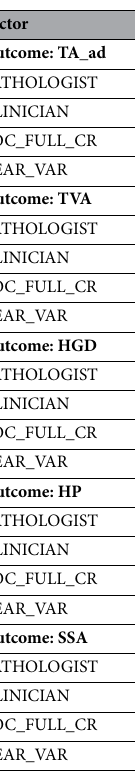
Table 4. Generalized linear model results. “PATHOLOGIST” and “CLINICIAN” are variables that represent individual pathologists and individual submitting physicians/surgeons. “LOC_FULL_CR” is a variable that reperesent the anatomical location; it can be one of nine locations in the colon/rectum (rectum, rectosigmoid colon, sigmoid colon, descending colon, splenic flexure of colon, transverse colon, hepatic flexure of colon, ascending colon, cecum). “YEAR_VAR” is the year in which the specimen was accessioned. “DF” is the degrees of freedom. Tubular adenoma and adenoma NOS (TA_ad) were lumped in this analysis, as a subset of pathologists (early in the study period) signed cases as “adenoma” without further specifying. These are presumed to represent tubular